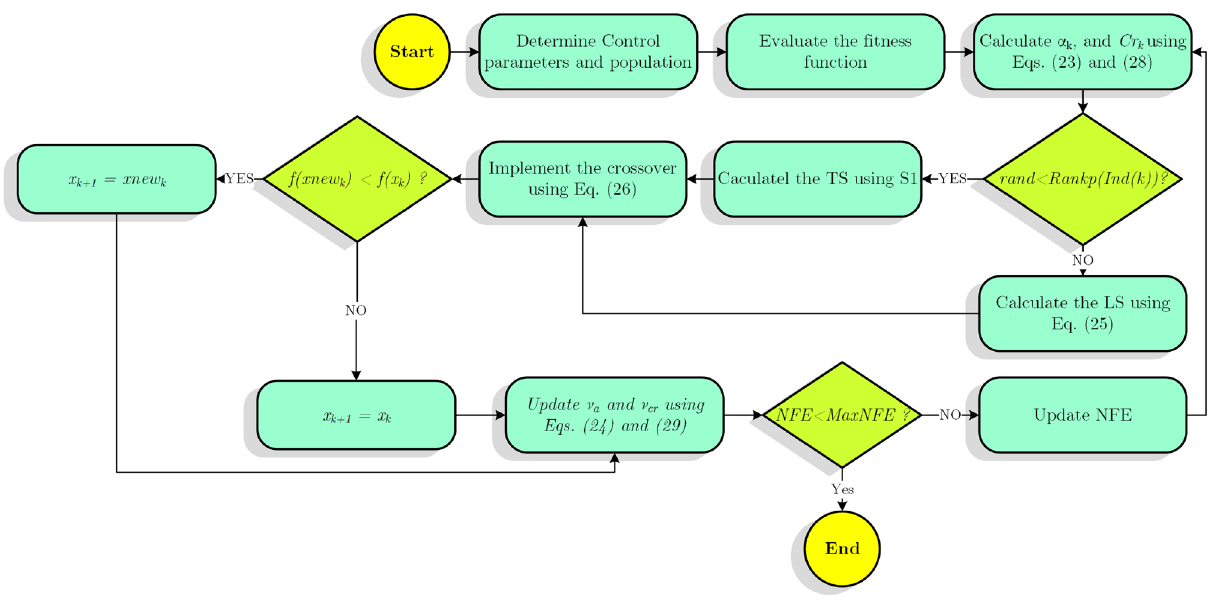
Figure 5. Flowchart of